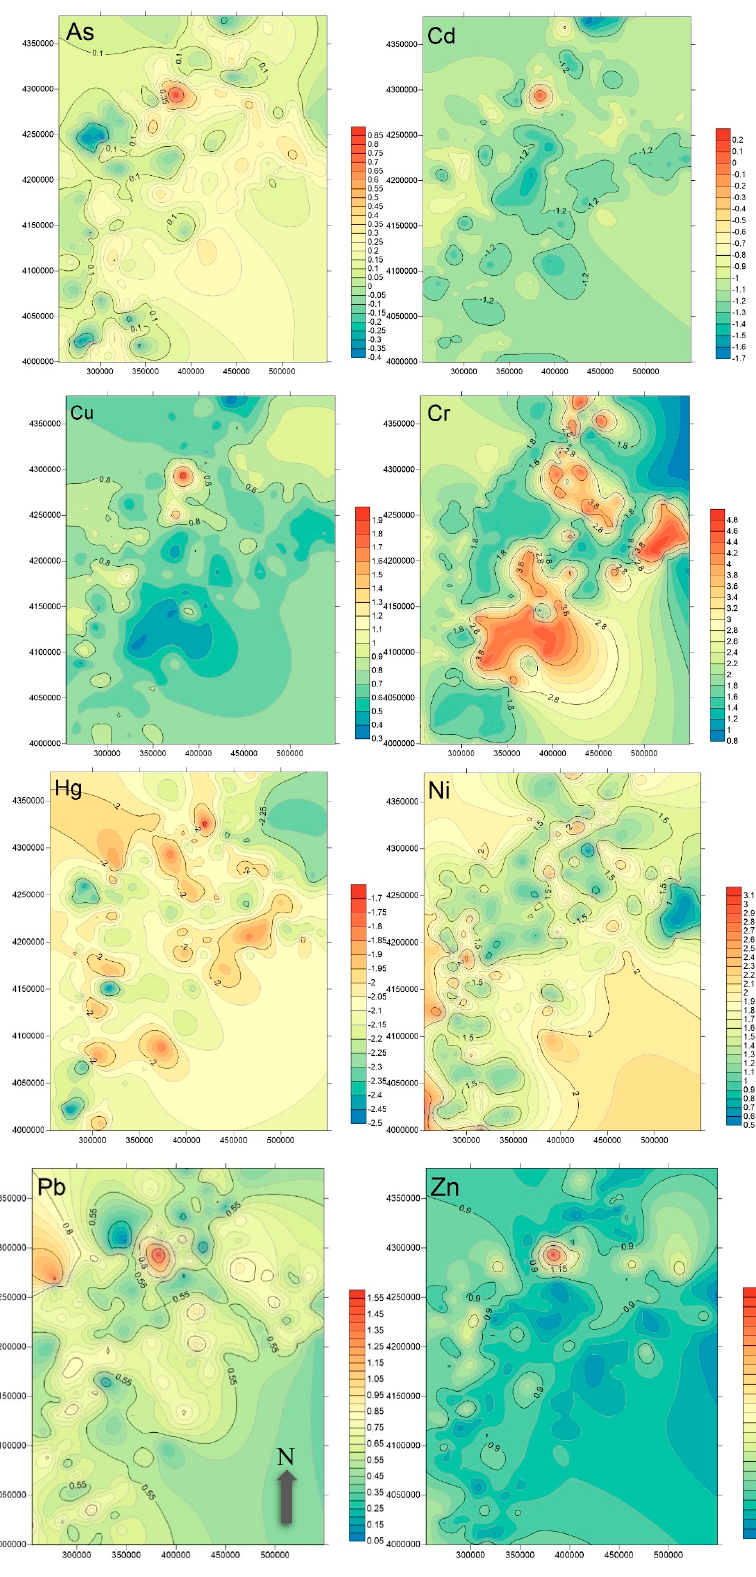
Figure 2. The predict map of WECH (the concentration’s sum of water-soluble, exchangeable, carbonate-bound and humic acid-bound) of trace metal(loid)s by Kriging method.